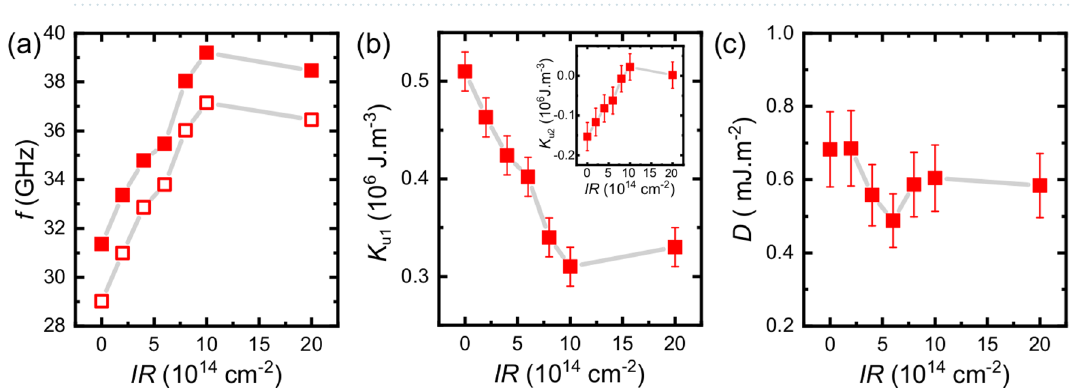
Figure 6. ( a ) Evolution of the absolute values of the Stokes (full dots) and anti-Stokes (open dots) frequencies measured for positive applied field µ 0 H = 1.5 T, as a function of the IR. ( b ) The first order out-of-plane uniaxial anisotropy constant ( K u 1 ) as a function of the IR. Inset: The second order uniaxial anisotropy constant K u2 obtained from the difference of the effective constant obtained by FMR and the first-order constant obtained by BLS. ( c ) Values of the DMI constant D = (π M s � f )/ 2 γ k derived from the frequency asymmetry between the anti-Stokes and Stokes peaks (cid:31) f of the Fig.